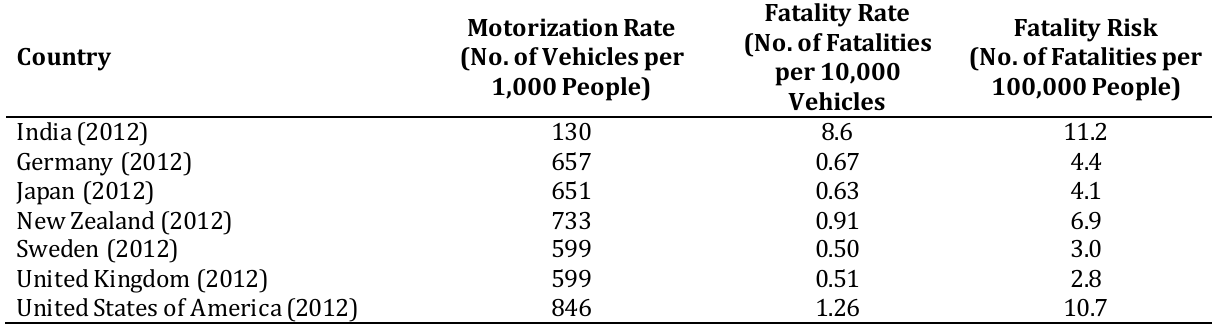
Table 2: Comparison of fatalities for different countries Country